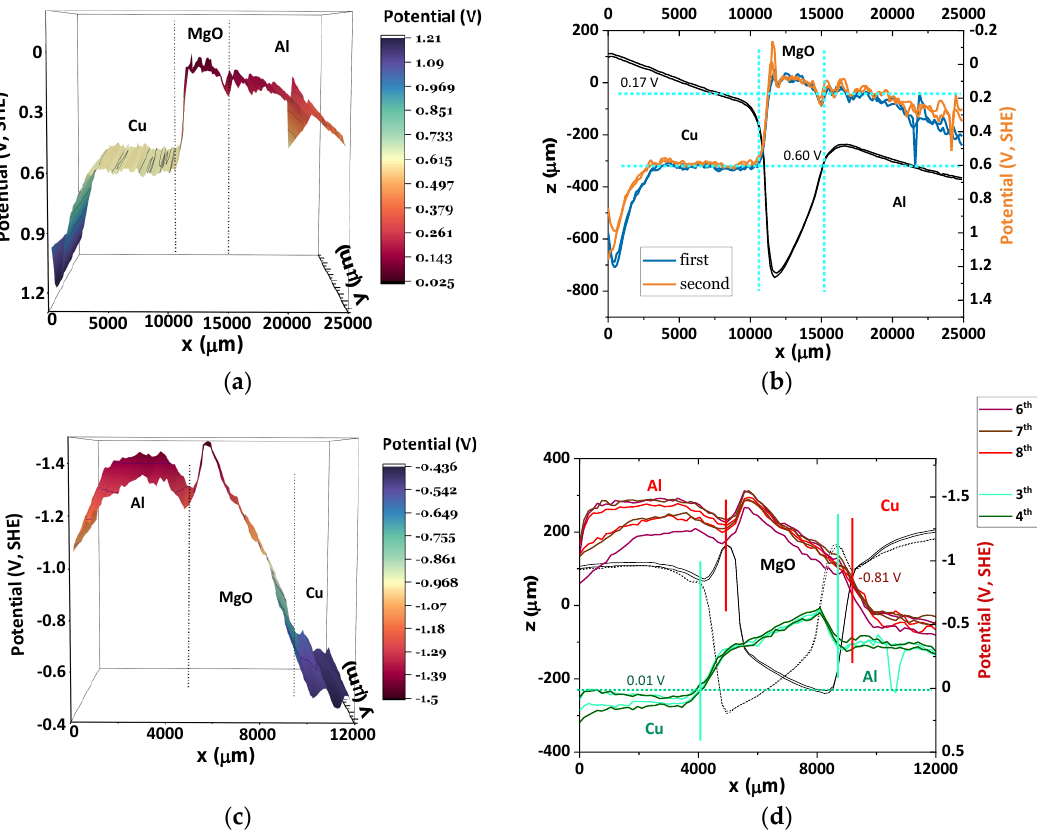
Figure 4. Topography and surface chemical potentials for an Al/MgO/Cu cell show different energies for the equalization of the surface chemical potentials of the heterojunctions Cu/MgO, MgO/Al, and Al/MgO: ( a , b ) extended SKP analyses showing n-type semiconductor band bending denoted by the surface chemical potential of MgO when Cu was connected to the SKP; equalization of Cu/MgO surface chemical potentials with the Al’s is made through a positively polarized spike at the surface of the Al; ( c ) straight band bending denoted by the surface chemical potential of MgO when Al is connected to the SKP mirroring ( a ); ( d ) SKP analyses showing the differences for when the Al or the Cu are connected to the instrument. The electrode that is connected to the SKP is able to achieve similar surface chemical potentials to the absolute chemical potentials widely available in the literature represented by [38]; for example, Al reaches − 1.45 V (SHE) in ( c ) for a tabulated value of − 1.66 V (SHE)